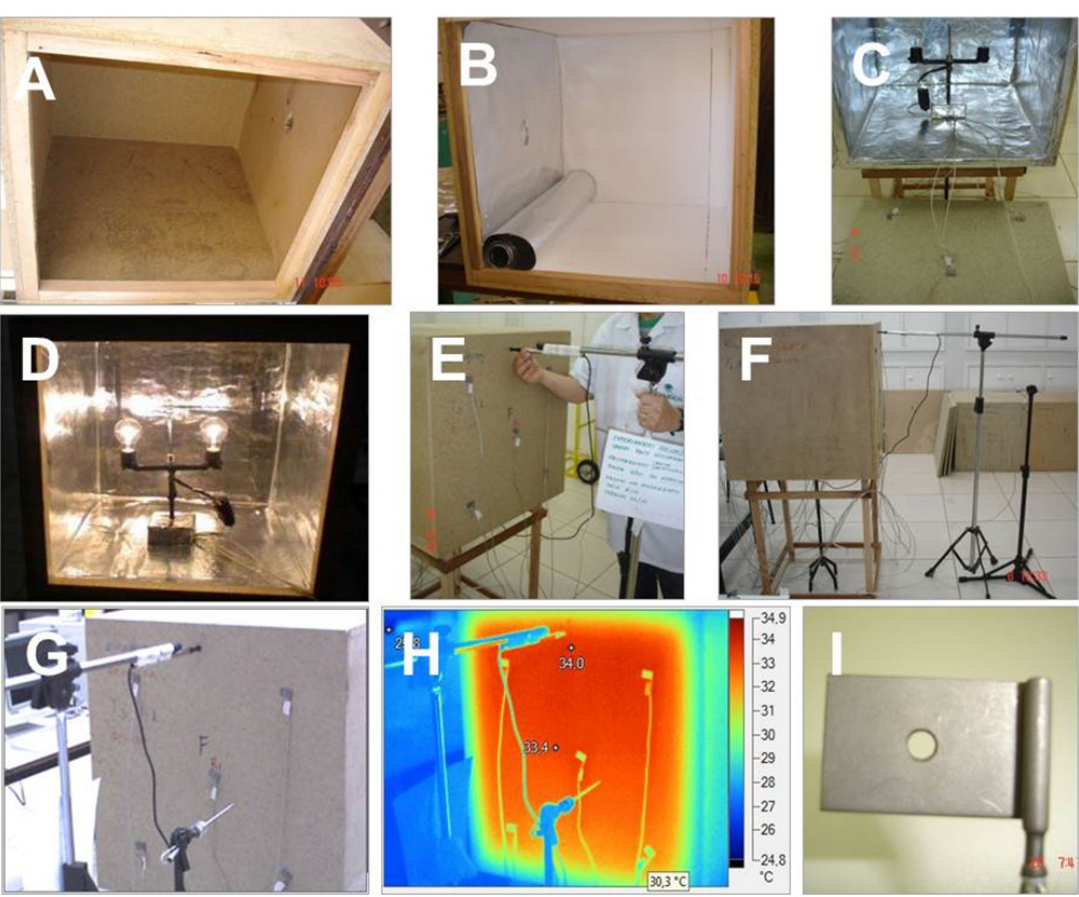
Figure 1. Assembly sequence of the experiment, in which: (A) module ready; (B) internal coating with foam and aluminized blanket; (C) device containing the heat source turned off and the sensor attachment on the inner face of the lid; (D) device containing the heat source turned on; (E) placement of sensors on the outside and hot wire thermo-anemometer; (F) final assembly of the experiment; (G and H) thermographic photo with color alarm deactivated and activated, espectively; (I) detail of the contact sensor type k with the attachment